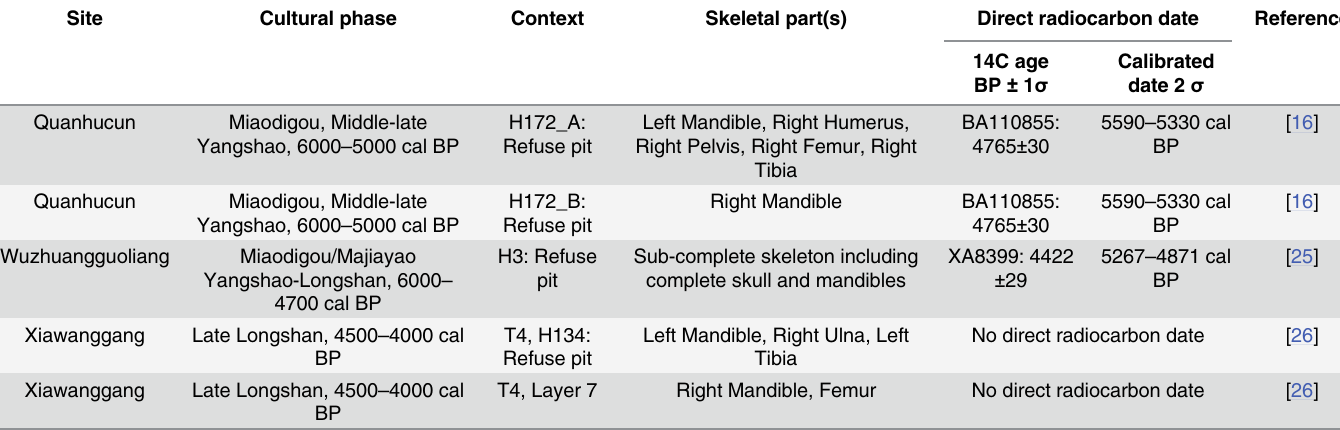
Table 1. Archaeological information for the five Chinese cat